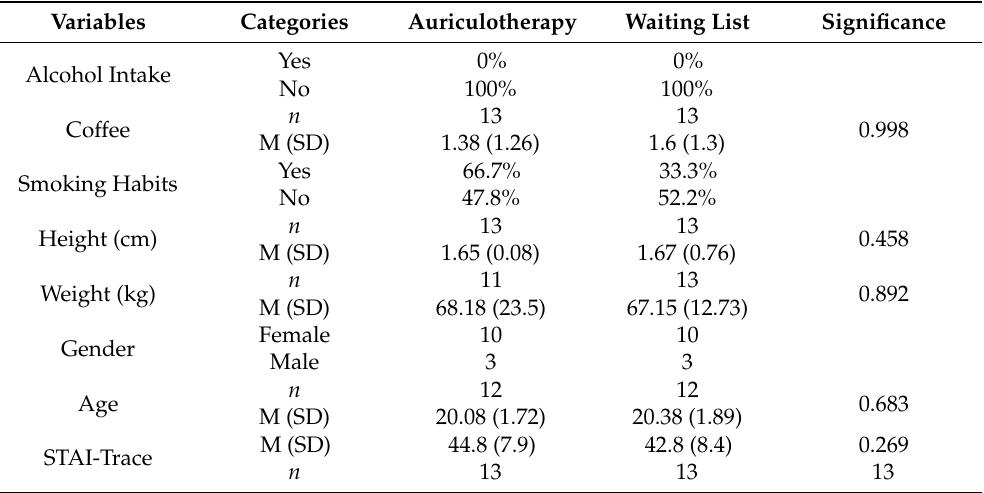
Table 1. Demographic